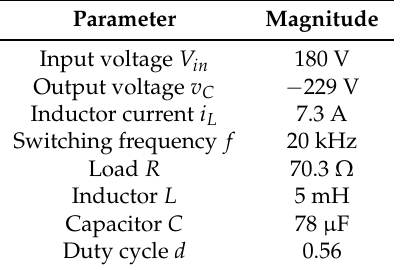
Table 1. Buck-Boost converter operation parameters.